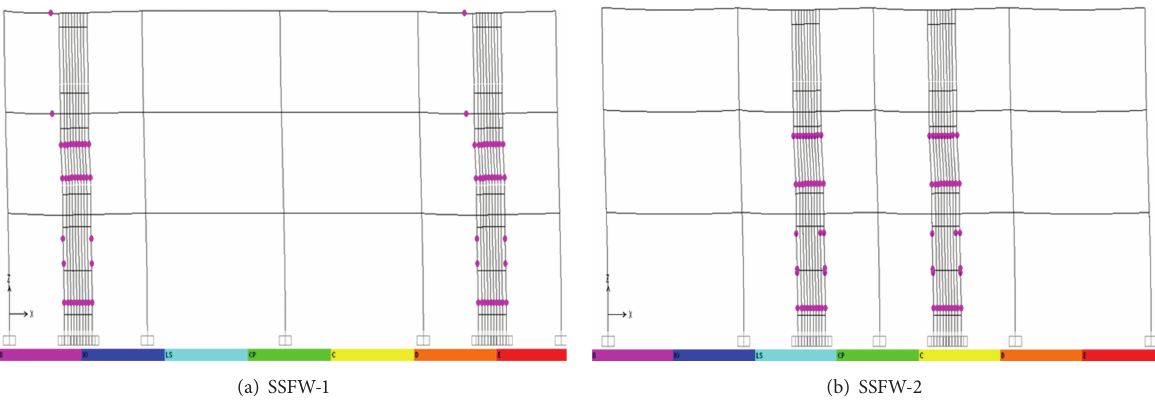
Figure 22: Distribution of plastic